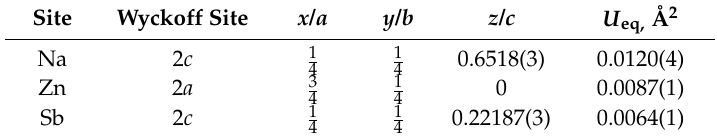
Table 2. Atomic coordinates and isotropic equivalent displacement parameters of